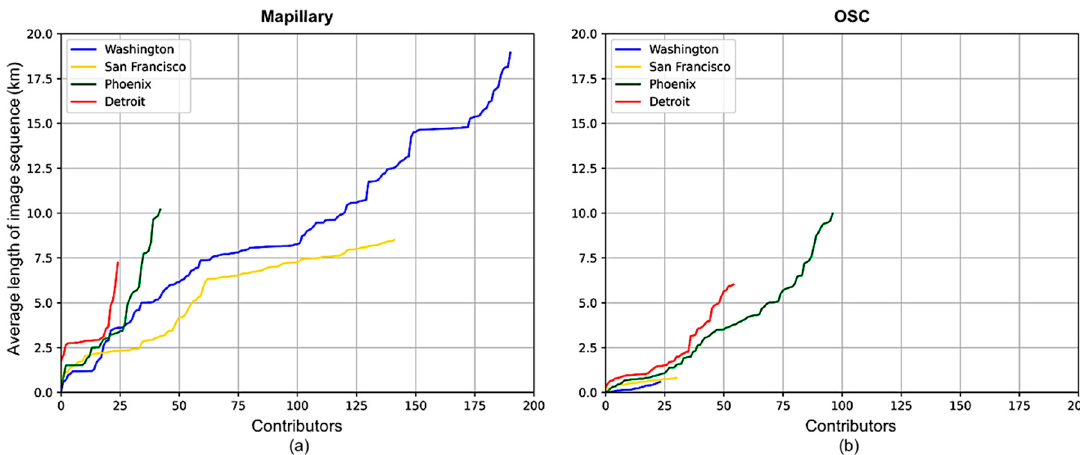
Figure 9. Average length of road sequence contributed per user in ( a ) Mapillary and ( b ) OSC. Table 5. Percentage of 1 × 1 km grid cells mapped more than once by the same users.